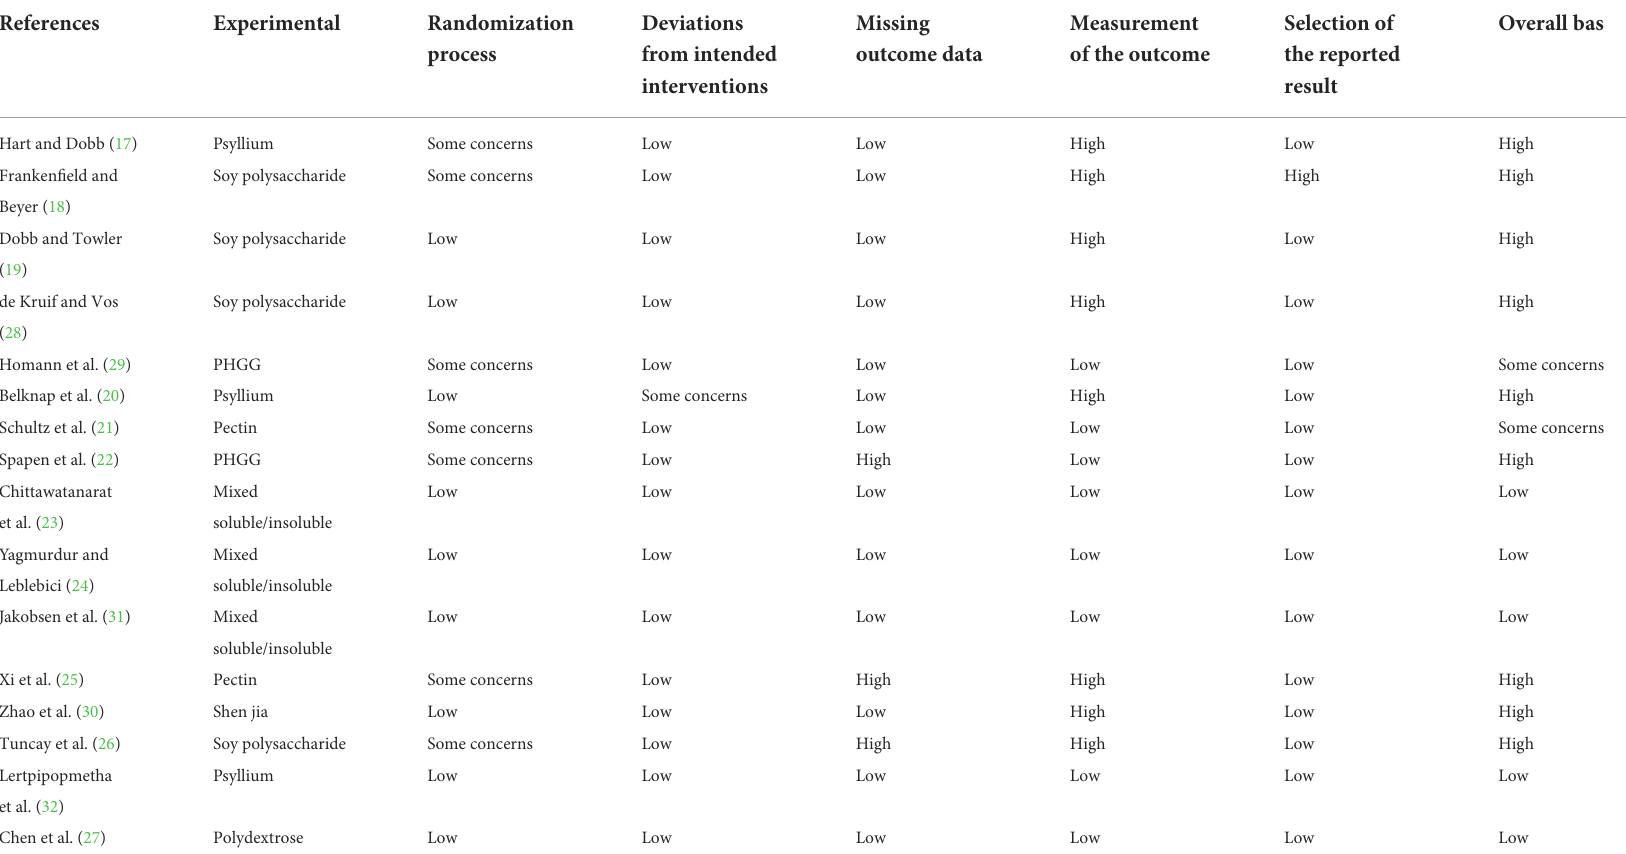
TABLE 2 Risk of bias of included